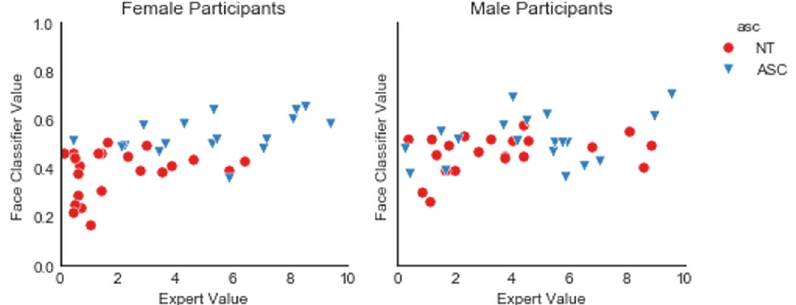
Fig. 1 Automated classi fi cation based on facial expression separated by gender. Table 1. Gaze behavior separated by groups.